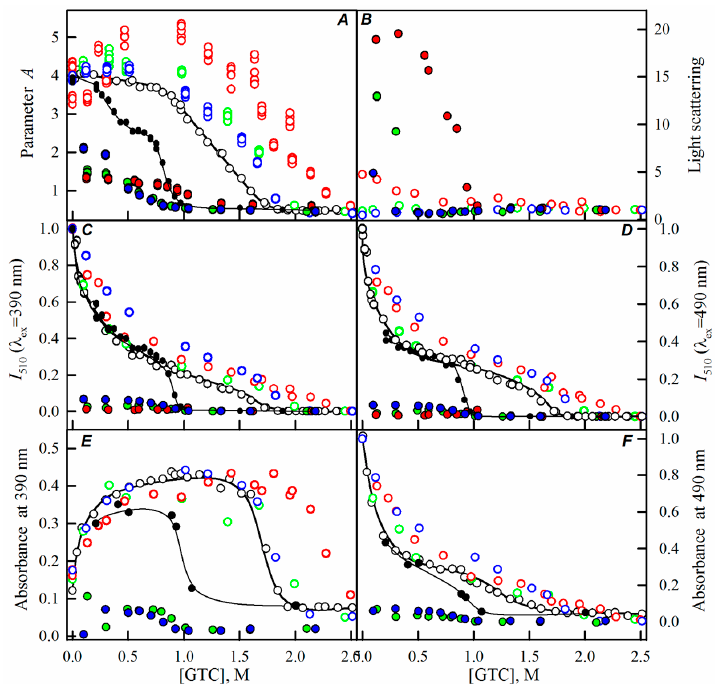
Figure 3. The effect of crowding agent PEG-8000 on the sfGFP conformational changes induced by GTC. For more details see the legend of Figure 2. Applied concentrations of PEG-8000 were 8% (blue circles), 12% (green circles), and 30% (red circles).